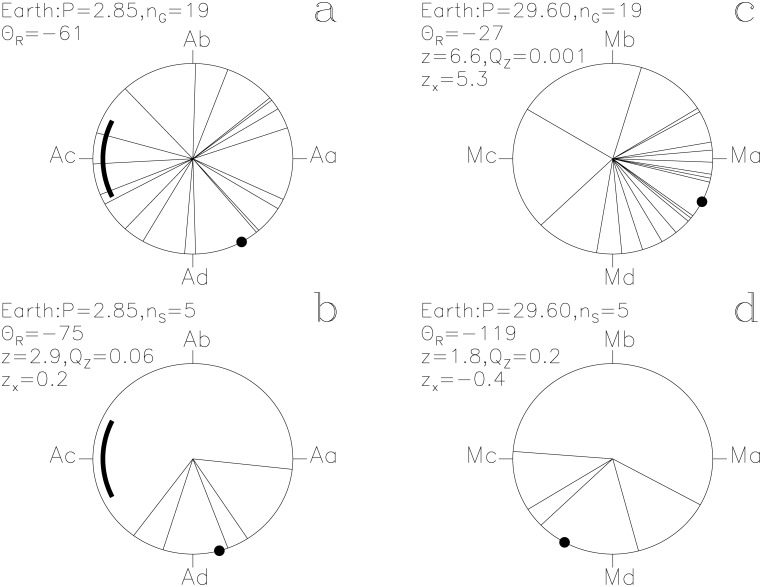
Earth.otherwise as in Fig 1